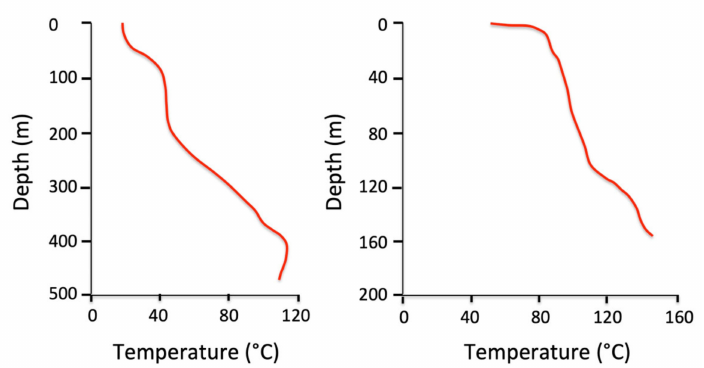
Figure 5. Temperature profiles of the Bagnoli 1 well (( left ), Reference [39]) and of the Agnano well (( right ), measured with thermocouple